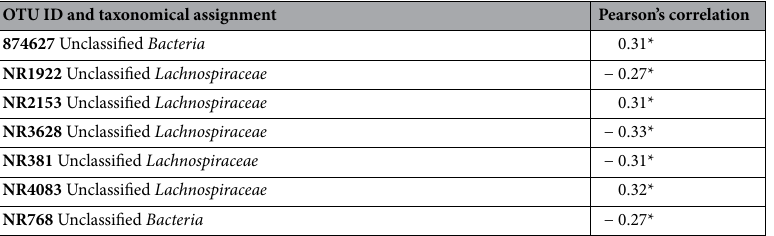
Table 7. Taxonomic assignment of the OTUs selected in the sPLSR analysis for ADRFI AL . ADRFI AL , average daily residual feed intake in rabbits fed ad libitum. * P for Pearson’s correlation t-test between the relevant OTU and ADRFI AL lower than